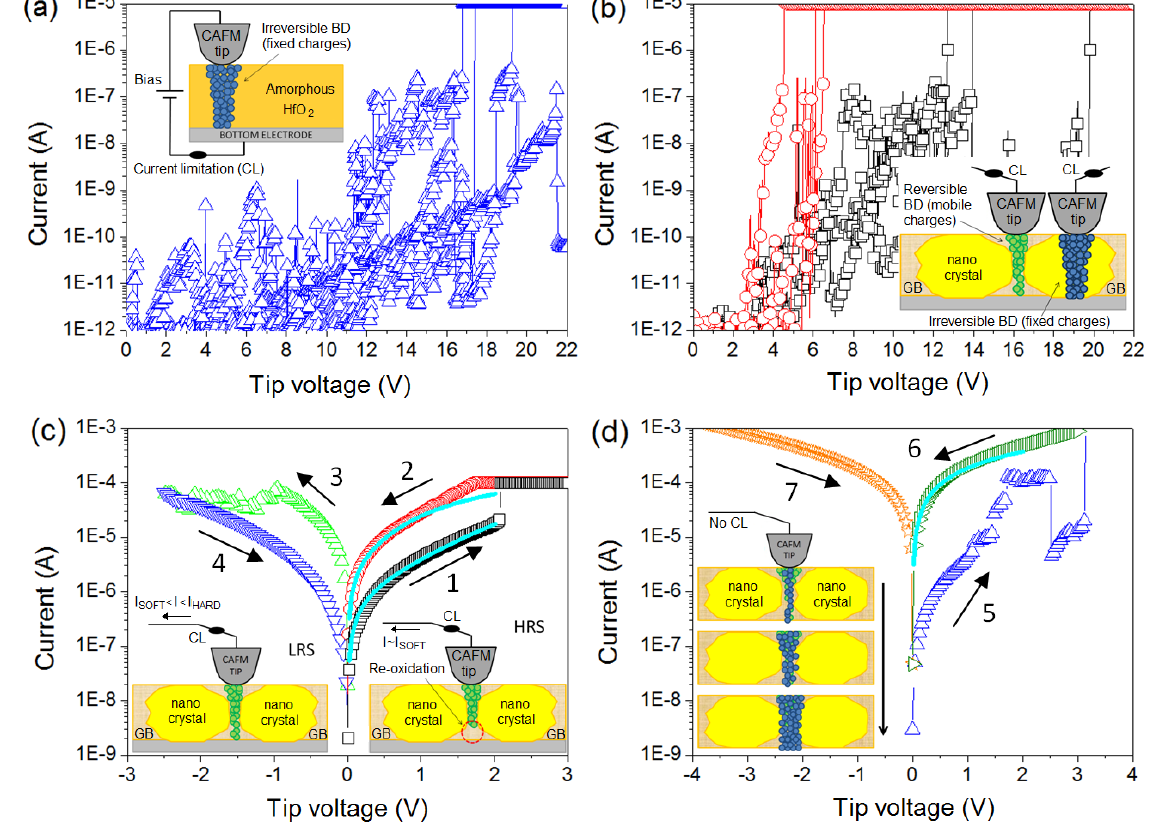
Figure 9. Forming process at different random locations on ( a ) a non-annealed amorphous 3 nm HfO ; and ( b ) annealed polycrystalline 3 nm HfO . The polycrystalline sample shows 2 2 two different IV patterns associated with low and high forming voltages; ( c ) An example of RS behavior observed at the low voltage-forming site in ( b ); ( d ) An example of the creation of an irreversible CF at a GB location (similar to that in ( c )) when the forming is performed without current limitation. The schematics indicate the probing